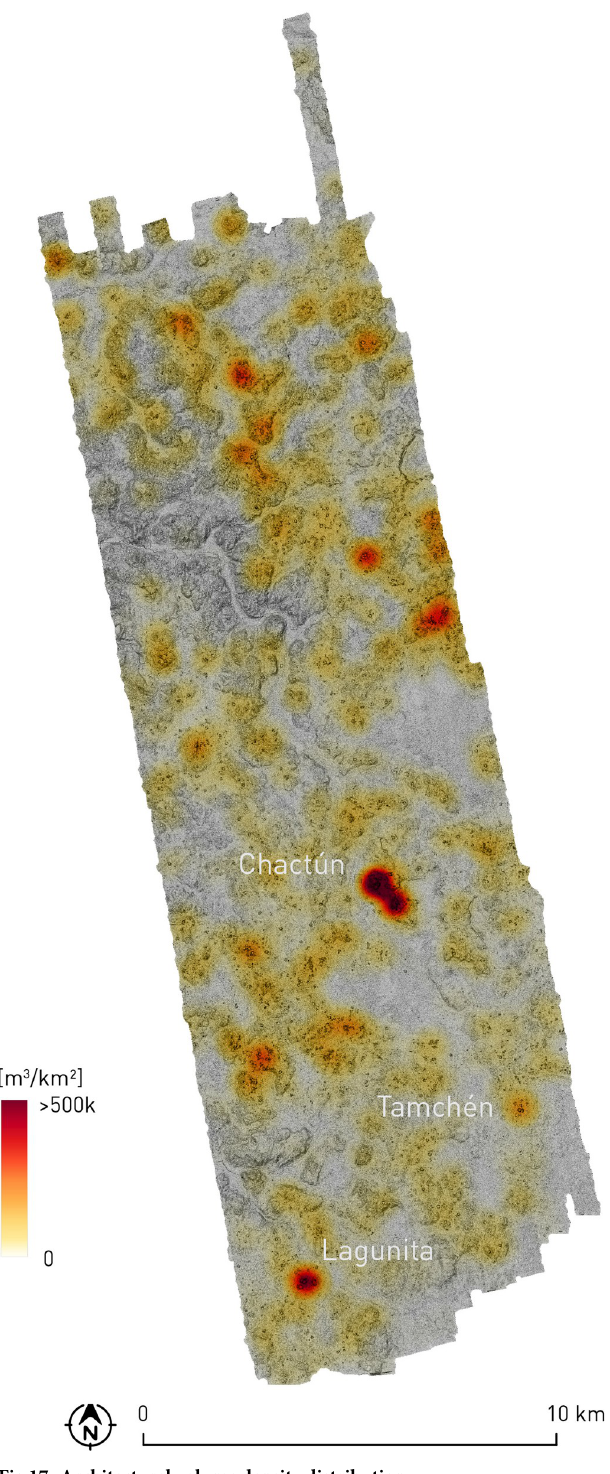
Fig 17. Architectural volume density